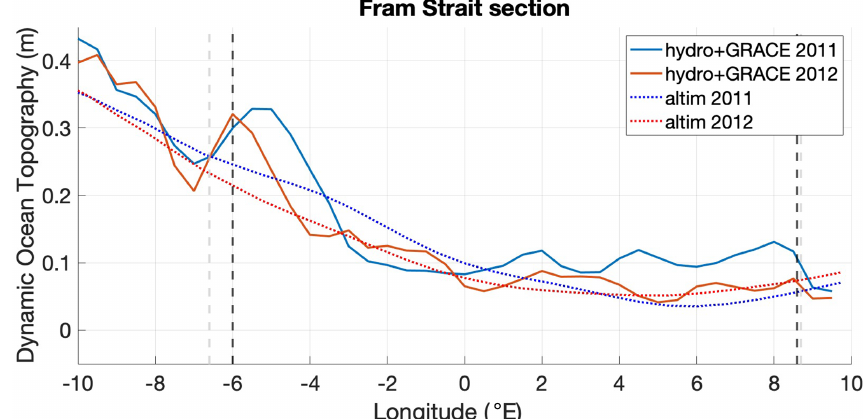
Figure 8. Cross sections of η across the Fram Strait at 79 ◦ 50 (cid:48) N in June 2011 and June 2012. Altimetry-derived η is displayed against steric height h S from in situ hydrographic sections plus ocean bottom pressure h P from GRACE. Light grey and dark grey vertical dashed lines indicate the 300 and 400m isobaths,